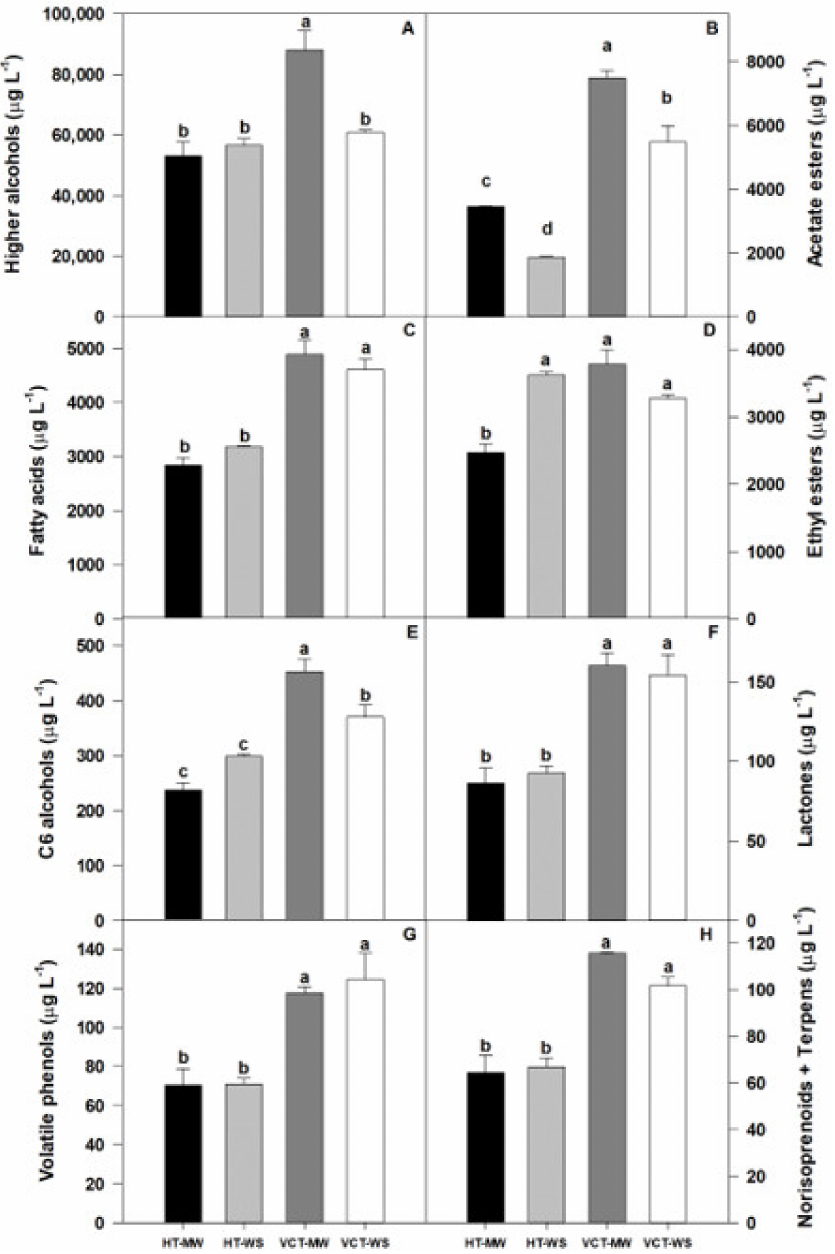
Figure 2. Maturana Blanca wine volatile families (expressed in µ g L − 1 ): ( A ) alcohols, ( B ) acetates esters, ( C ) volatile acids ( D ) ethyl esters, ( E ) C6 compounds, ( F ) lactones, ( G ) volatile phenols and ( H ) norisoprenoids + terpenes. Values are mean ± standard error of three replicates. Letters denote statistic significant differences between treatments ( p <